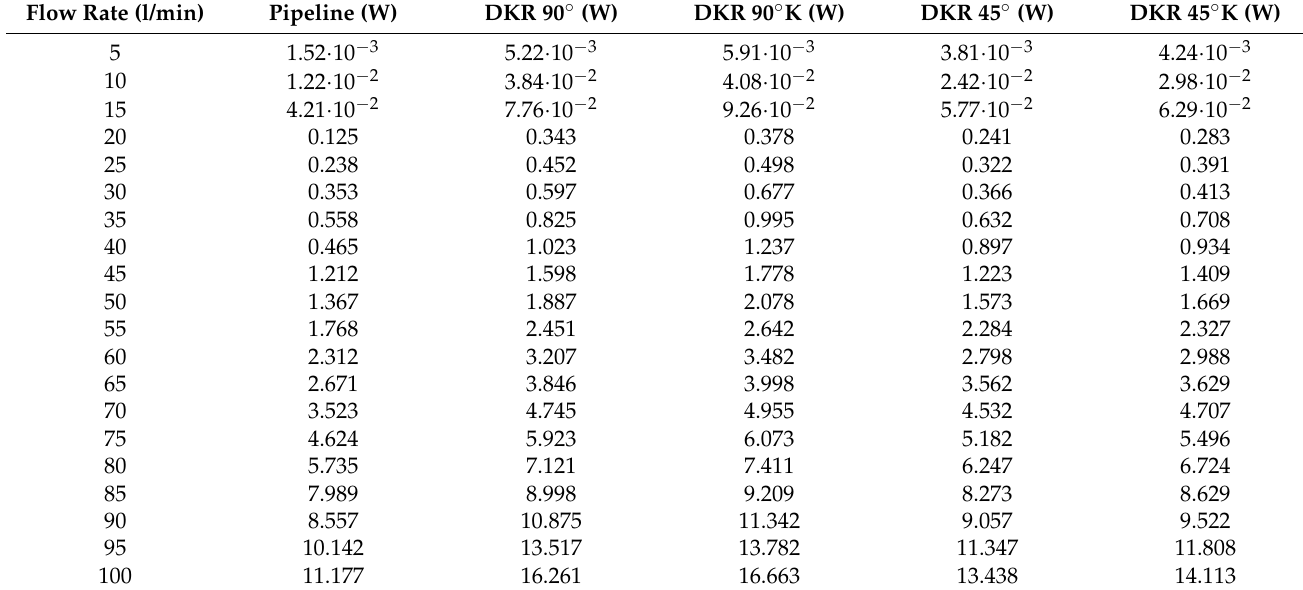
Table 1. Energy losses at angular fitting